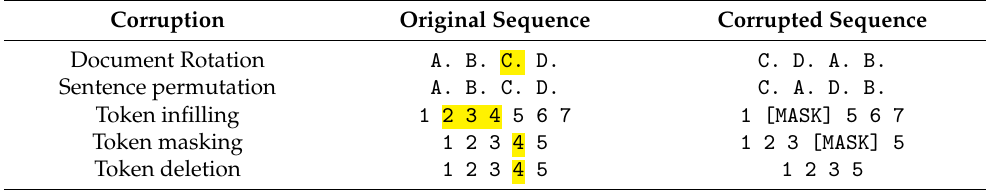
Table 1. Examples of the different denoising objectives. Capital letters represent sentences and numbers represent tokens. Each corruption is applied to the original sequence, and the resulting corrupted sequence is shown. The model is trained to reconstruct the original sequence using the corrupted sequence as input. Selected tokens or sentences are highlighted using a yellow background.